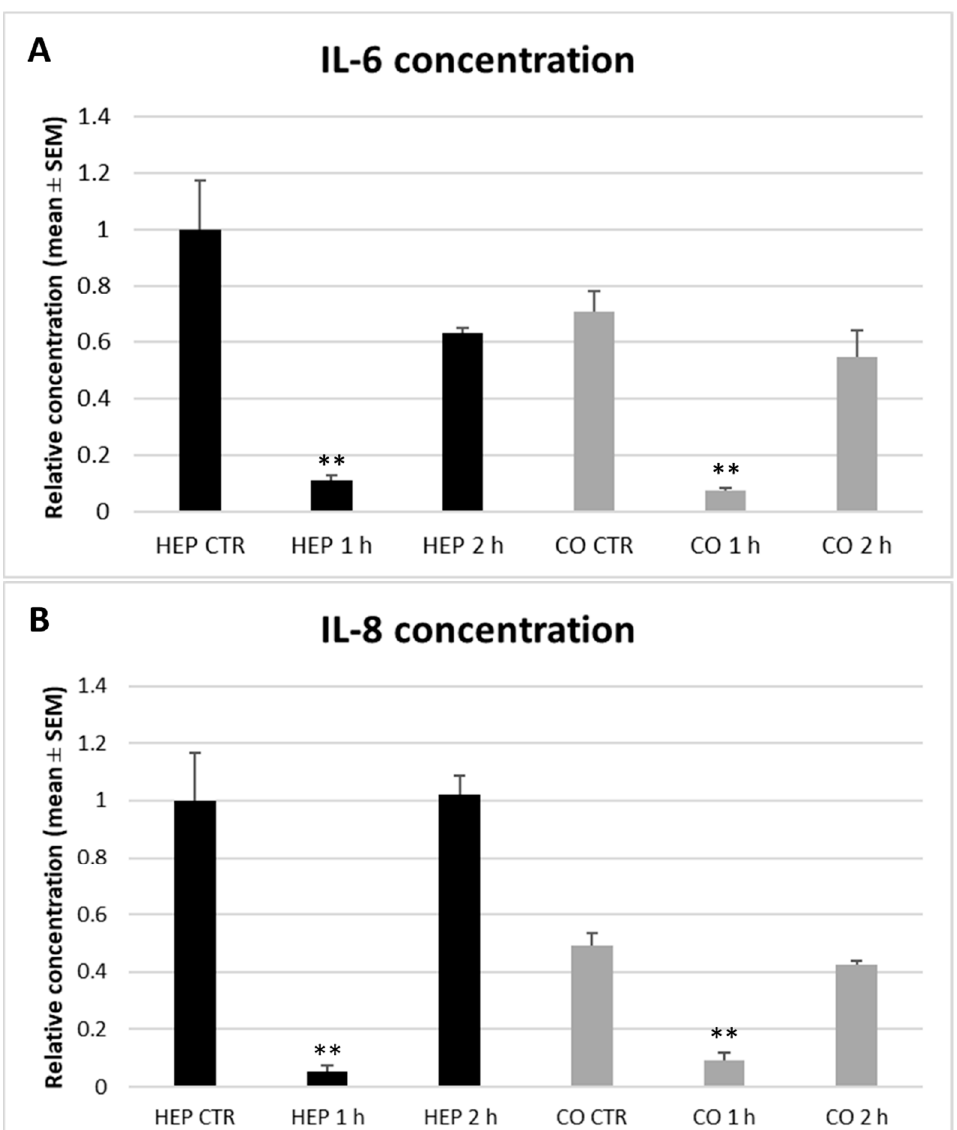
Figure 9. Interleukin-6 (IL-6, A) and interleukin-8 (IL-8, B) concentration in culture media of hepatocyte mono-cultures (“HEP”) and hepatocyte—nonparenchymal cell co-cultures (“CO”) detected by a chicken specific ELISA assay. The “CTR” refers to control cells with no heat exposure, while “1 h” and “2 h” indicate incubation of cell cultures at 43 ◦ C for 1 or 2 h, respectively. Relative concentrations were calculated by considering the mean value of control hepatocyte mono-cultures as 1. Results are expressed as mean ± standard error of the mean (SEM), n = 3 / group. Asterisks over bars of “1 h” and “2 h” refer to significant di ff erences compared to “CTR” cells within the same cell culture model. ** p < 0.01.